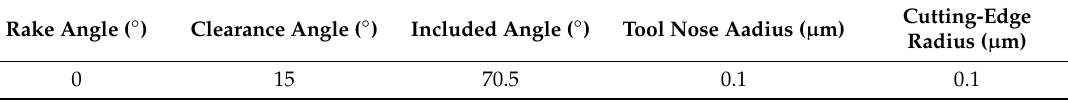
Table 1. Tool geometry parameters.